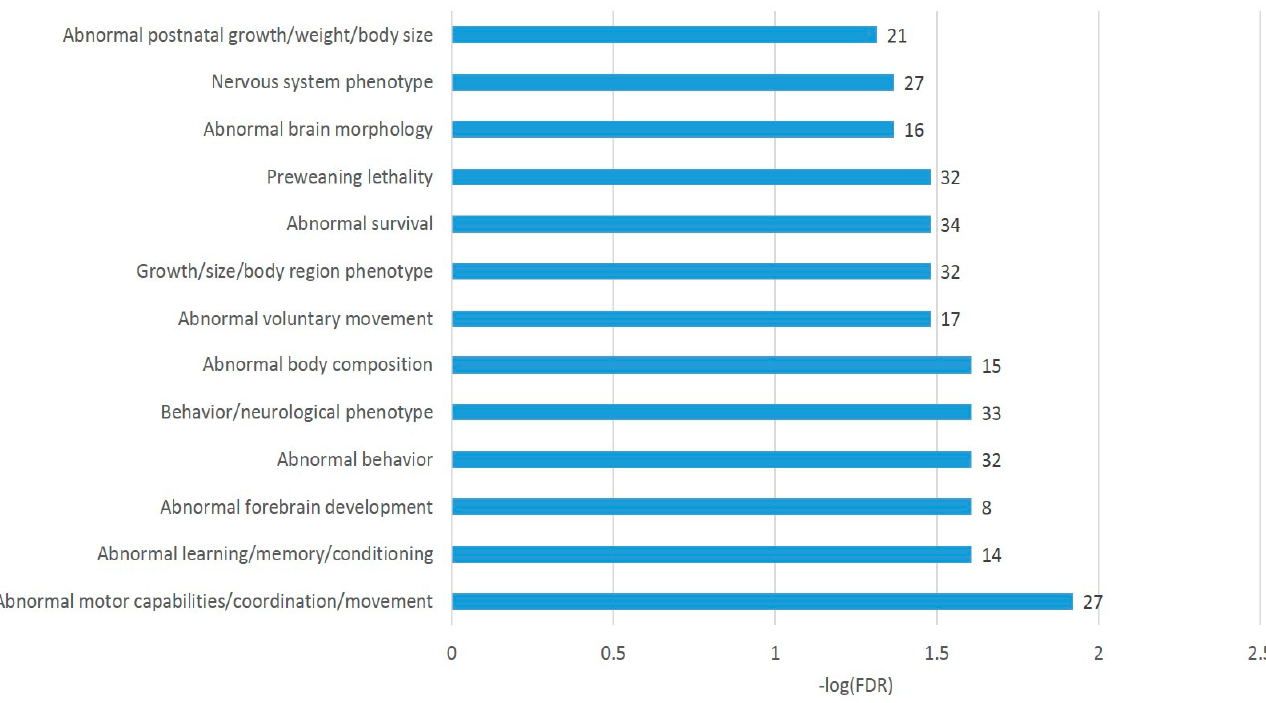
Figure 8. Annotation of 76 DAS ES genes attenuated in the A20 group (Figure 6c). See Table S2j for explicit GO information.